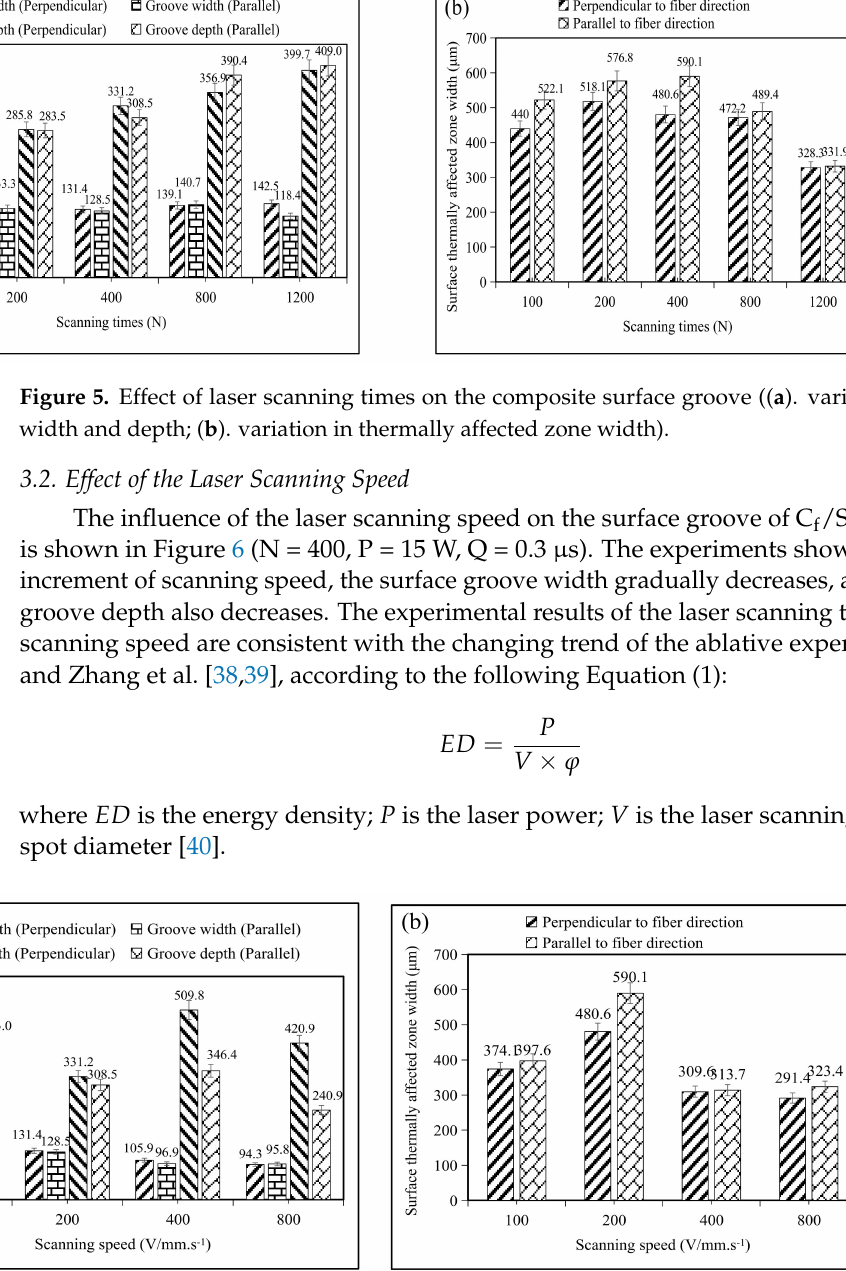
Figure 6. Effect of the scanning speed on the composite surface groove (( a ). variation in groove width and depth; ( b ). variation in thermally affected zone